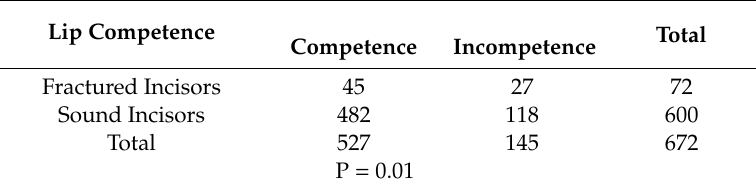
Table 1. Relationship between fractured incisors and lip